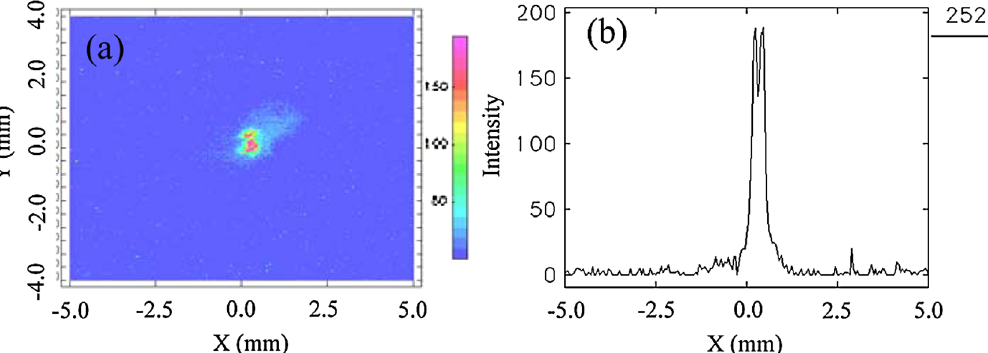
FIG. 5. (Color) OTR beam image (a) and horizontal profile (b) through a spike in distribution after BC with L2 phase ¼ 14 : 9 degrees , close to maximum